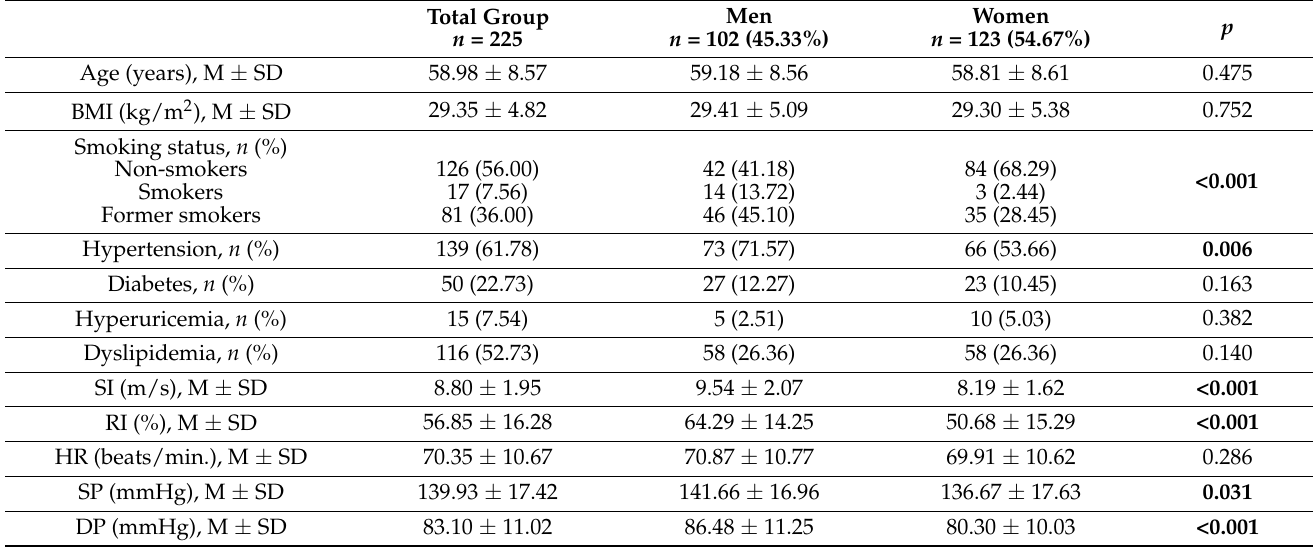
Table 1. Characteristics of the total group of COVID-19 convalescents and subgroups based on sex.